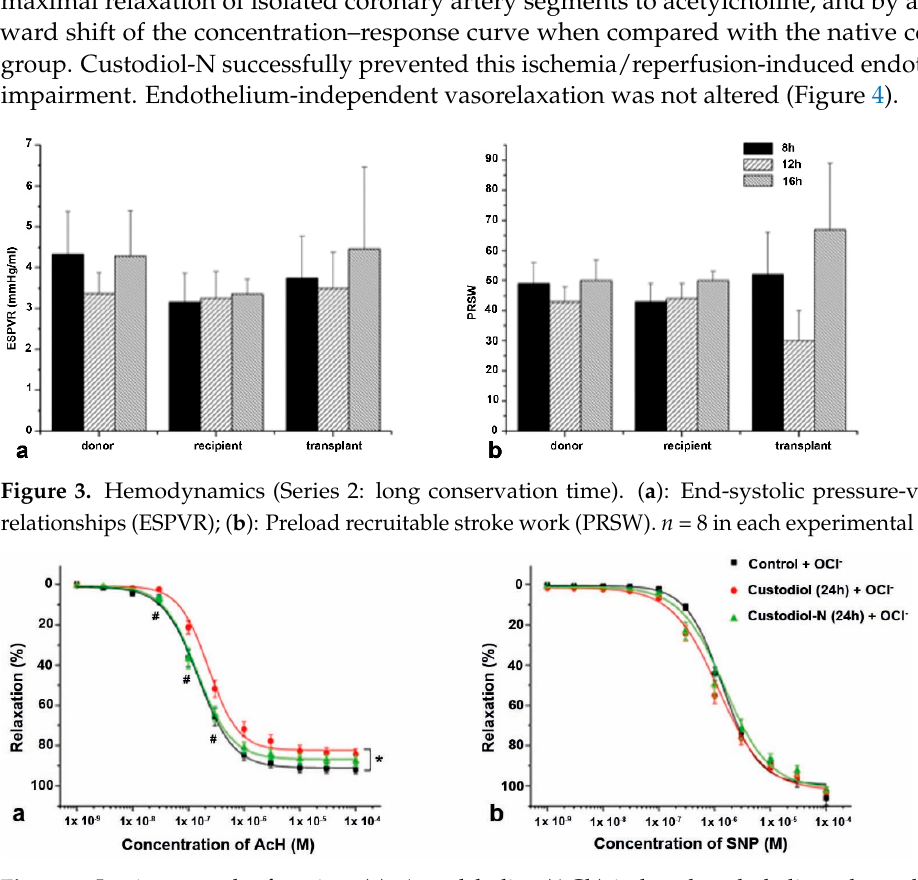
Figure 4. In vitro vascular function. ( a ): Acetylcholine (ACh)-induced, endothelium-dependent va- sorelaxation of native control isolated coronary arterial segments, and of arteries that underwent cold ischemic conservation for 24 h in Custodiol/Custodiol-N with added reactive oxidant hypochlorite (200 µ mol/L). ( b ): Sodium nitroprusside (SNP)-induced, endothelium-independent vasorelaxation of native control isolated coronary arterial segments, and of segments that underwent cold ischemic con- servation for 24 h in Custodiol/Custodiol N with added reactive oxidant hypochlorite (200 µ mol/L). Each point on the curves represents the mean ± SEM of 9–15 experiments in the different groups. * p < 0.05 vs. control, # p < 0.05 vs.